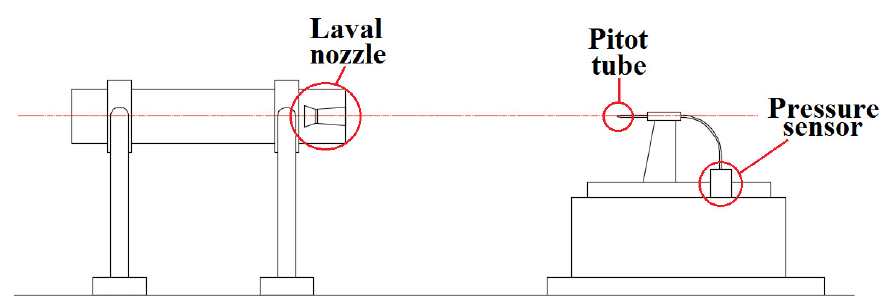
Figure 1. The schematic view of the employed apparatus in the